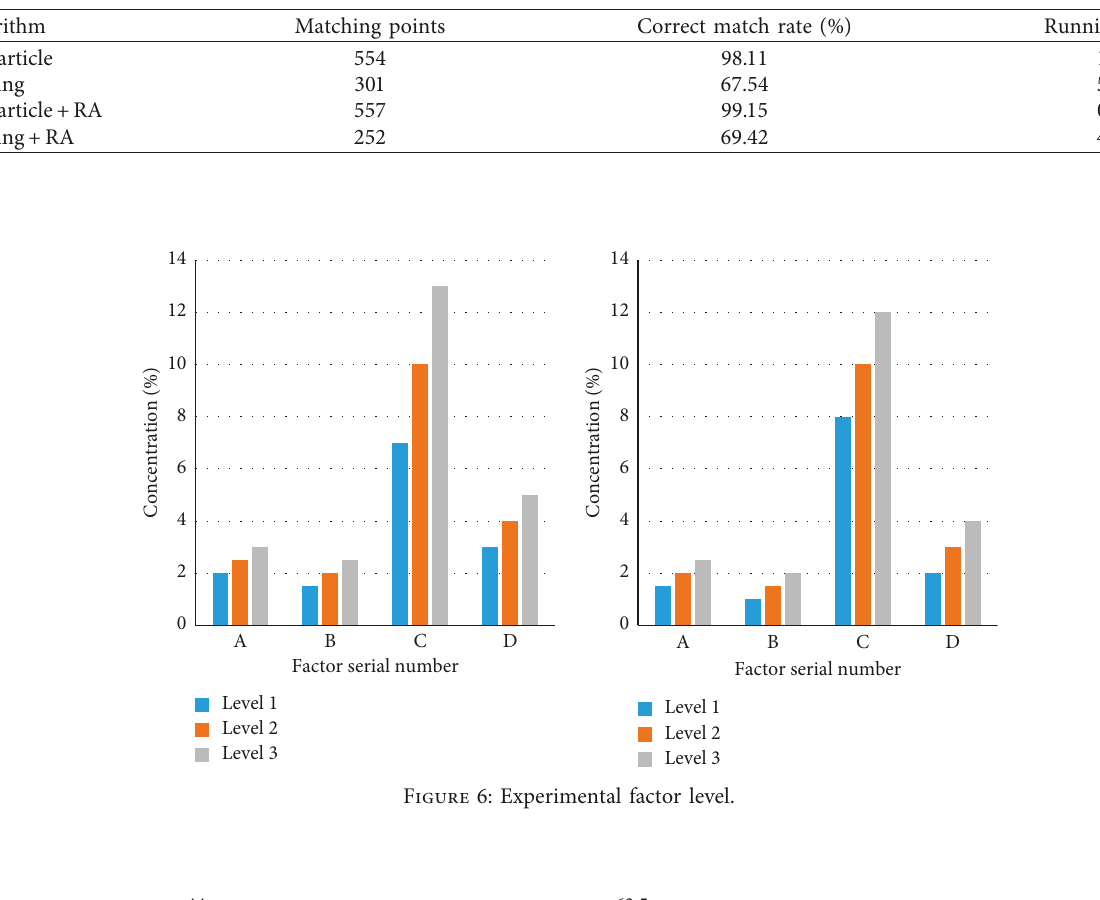
Table 3: Comparison of matching results after size change.